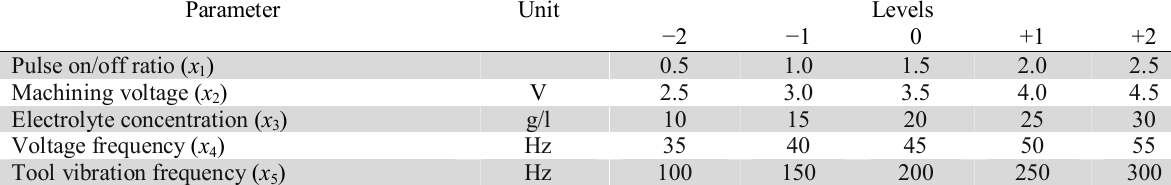
EMM process parameters and their levels (Munda and Bhattacharyya, 2008) Parameter Unit